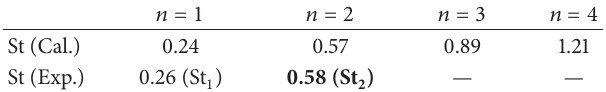
Table 2: Strouhal numbers of pressure oscillations resulting from a feedback mechanism calculated from (3) (longitudinal oscillation)